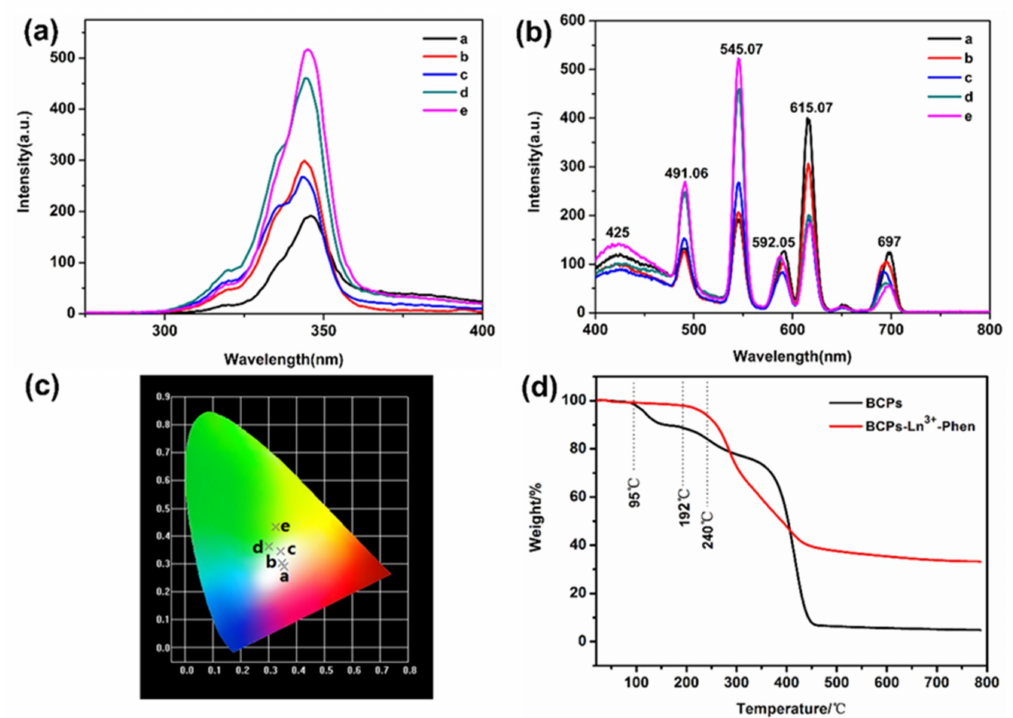
Figure 7. Fluorescence property, white light performance, and thermal stability of BCPs-Ln 3+ -Phen ( a ) Excitation spectra and ( b ) emission spectra of samples containing different molar ratio of Ln 3+ ions, Eu 3+ /Tb 3+ = 3:1 Eu 3+ /Tb 3+ = 2:1, Eu 3+ /Tb 3+ = 1:1, Eu 3+ /Tb 3+ = 1:2, Eu 3+ /Tb 3+ = 1:3, ( λ ex = 340 nm). ( c ) The CIE chromaticity coordinates of complexes a–e excited by 340 nm [a (0.355, 0.290), b (0.347,